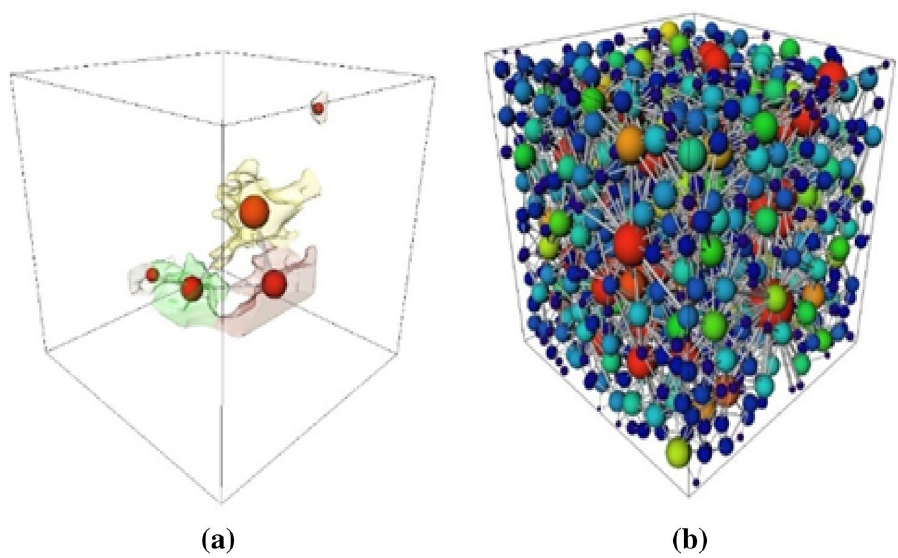
Figure 7. Demonstration of reconstructed pore network of one Loess sample from Lv Liang; ( a ) Abstracted pores (ball) and connections (stick), ( b ) pore network.